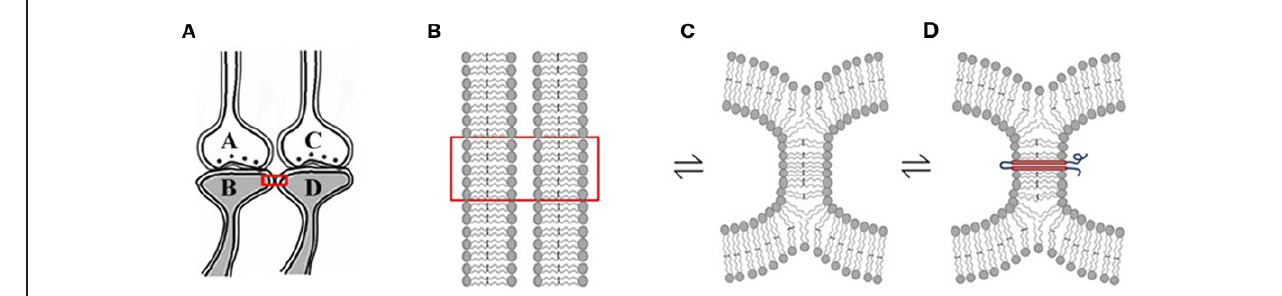
FIGURE 3 | Rapidly reversible, yet stabilizable hemi-fusion between the postsynaptic membranes of different neurons. (A) Closely located postsynaptic membranes that are simultaneously activated both during associative learning and LTP induction. A and C are presynapses and B and D are their corresponding postsynapses. (B) The boxed region in Panel (A) is expanded to show adjacently located postsynaptic cell membranes. (C) Simultaneous activation of the postsynapses both during learning and LTP induction can result in instantaneous hemi-fusion between the postsynaptic